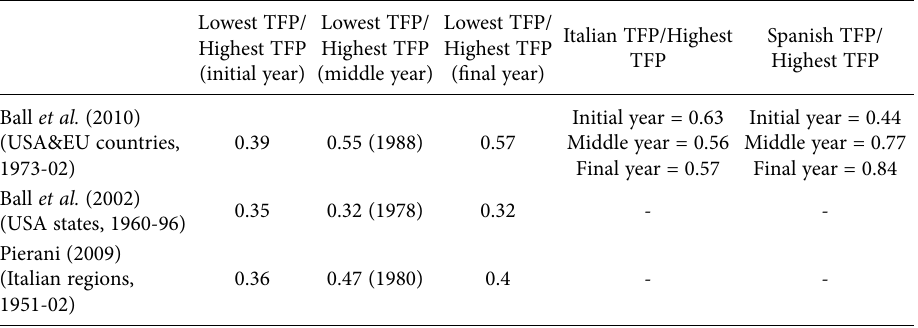
Table 5. Multilateral TFP comparison across countries, USA states and Italian